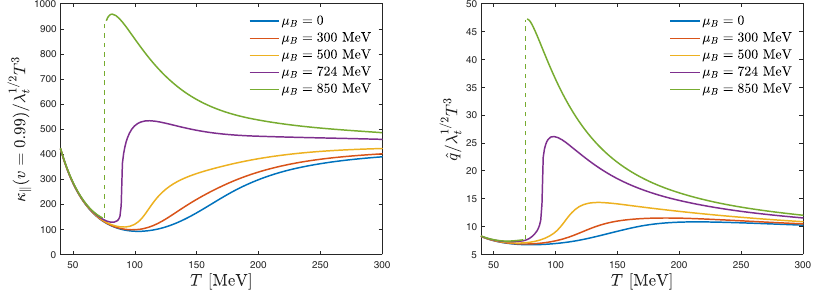
Figure 3. Parallel Langevin di ff usion at coe ffi cient v = 0 . 99 (left panel) and normalized jet quenching parameter ˆ q (right panel) as a function of the temperature for several values of µ B